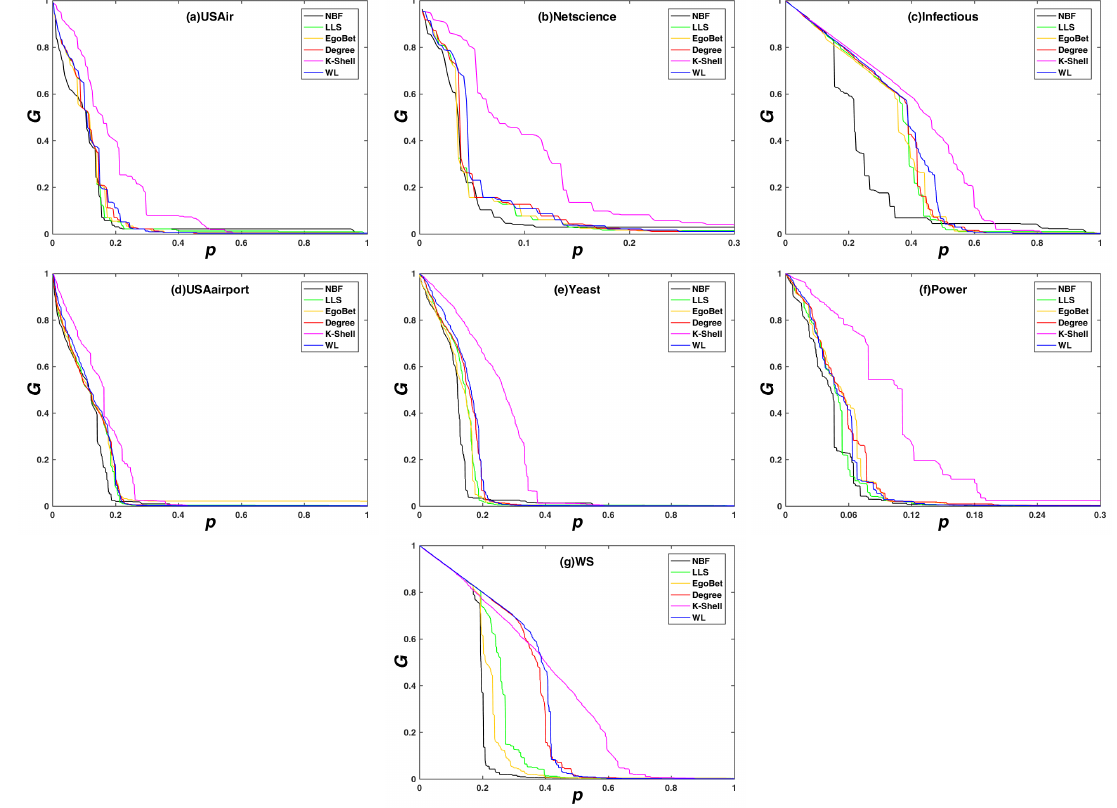
Figure 3. The network maximum connectivity coefficient ( G ) subjects with different dynamic attack strategies. Maximum connectivity coefficient ( G ) on the y -axis against the rate of removed node ( p ) on the x -axis. ( a ) the USAir network; ( b ) the Netscience network; ( c ) the Infectious network; ( d ) the USAirport network; ( e ) the Yeast network; ( f ) the Power network; and ( g ) the synthetic network